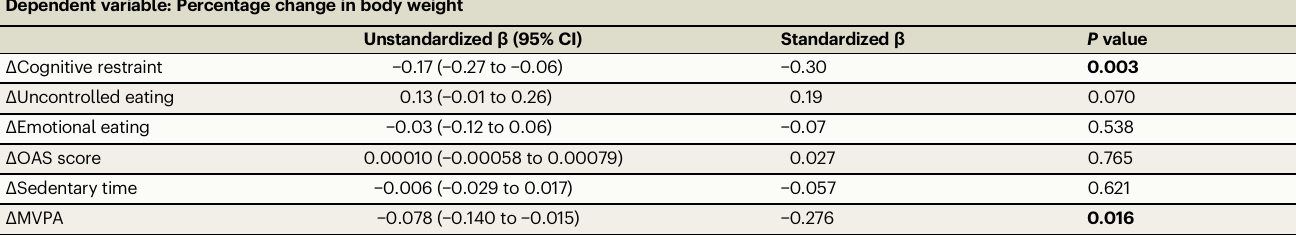
Table 5 | Associations between changes in eating and physical activity parameters and weight change Dependent variable: Percentage change in body